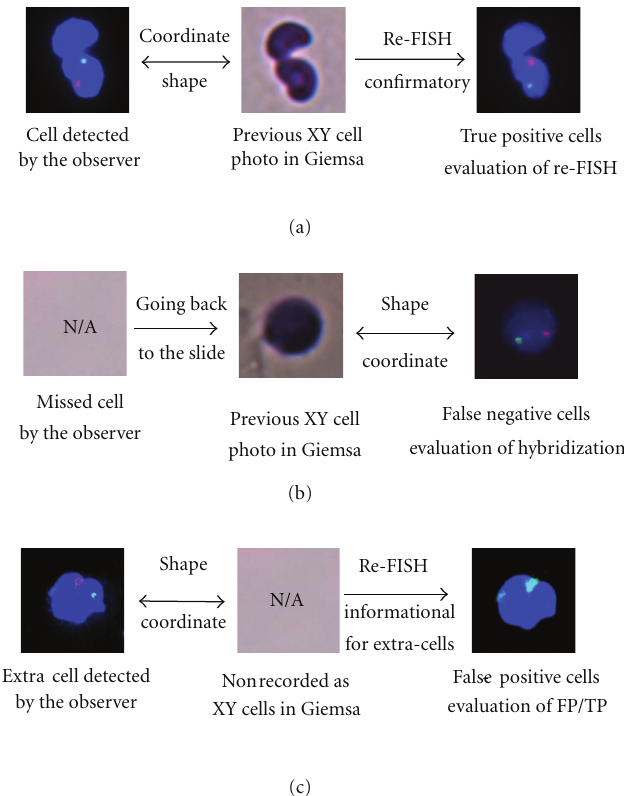
Figure 1: Schematic management of detected (a), missed (b), and extra cells (c). FP: false positive, TP: true positive, N/A: not acquired.